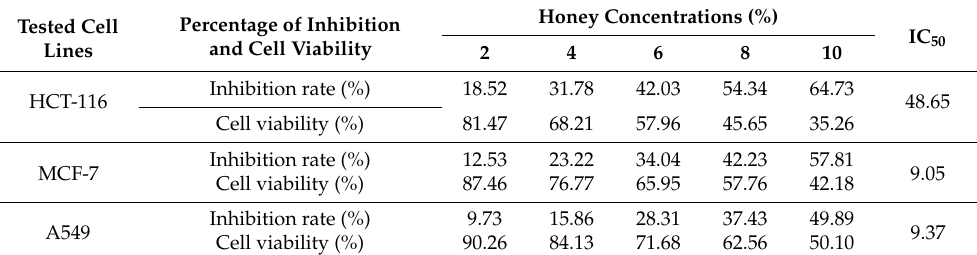
Table 5. Percentage of inhibition, cell viability, and IC 50 values of tested manuka honey against various cancer cell